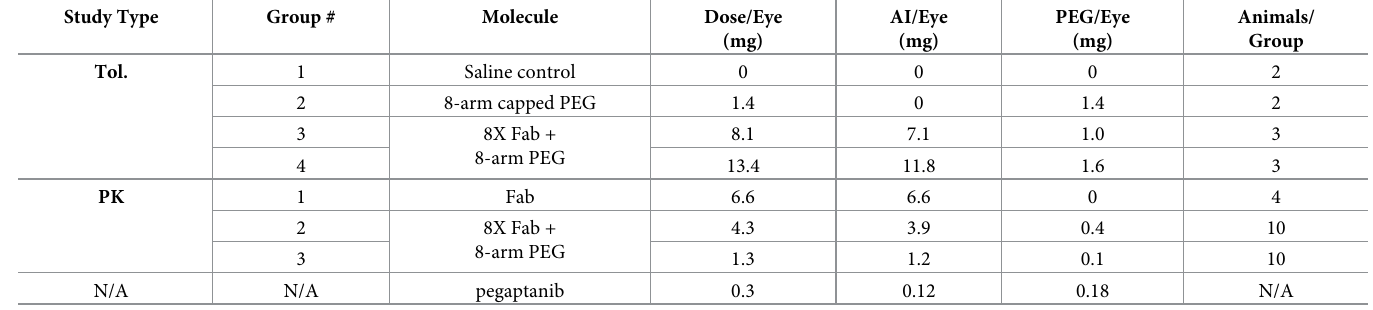
Single dose IVT administrations in cynomolgus (cyno) monkeys of saline, an N-ethylmalei- mide capped 8-arm capped PEG and 8X Fab + 8-arm PEG at doses of 8.1 and 13.4 mg/mL Fab (Table 3) with 29-day follow up, were well tolerated on clinical ophthalmic examination up to the highest dose tested. White vitreous floaters which may have represented test article, were observed during ophthalmic examination in eyes administered 8X Fab+8-arm PEG at both dose levels. The incidence, duration and size of these vitreous opacities followed a dose- response pattern such that the vitreous floaters were larger, more frequent and more persistent in eyes administered the highest dose of 8X Fab + 8-arm PEG. Table 3. NHP tolerability (Tol.) and PK study details. Dosing was performed via bilateral IVT injection of 0.1 mL dosing solution per eye. Pegaptanib was included for reference where N/A denotes “not applicable”. Study